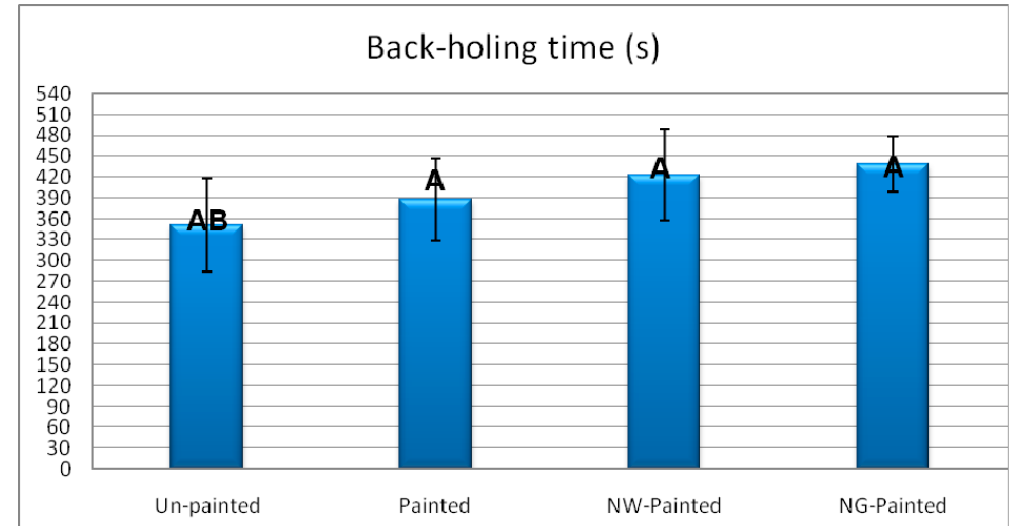
Figure 6. Back-darkening and back-holing times, in the four treatments of beech specimens (NW = nanowollastonite; NG = nano-graphene) (Letters on each column represent Duncan groupings at 95% level of confidence.).